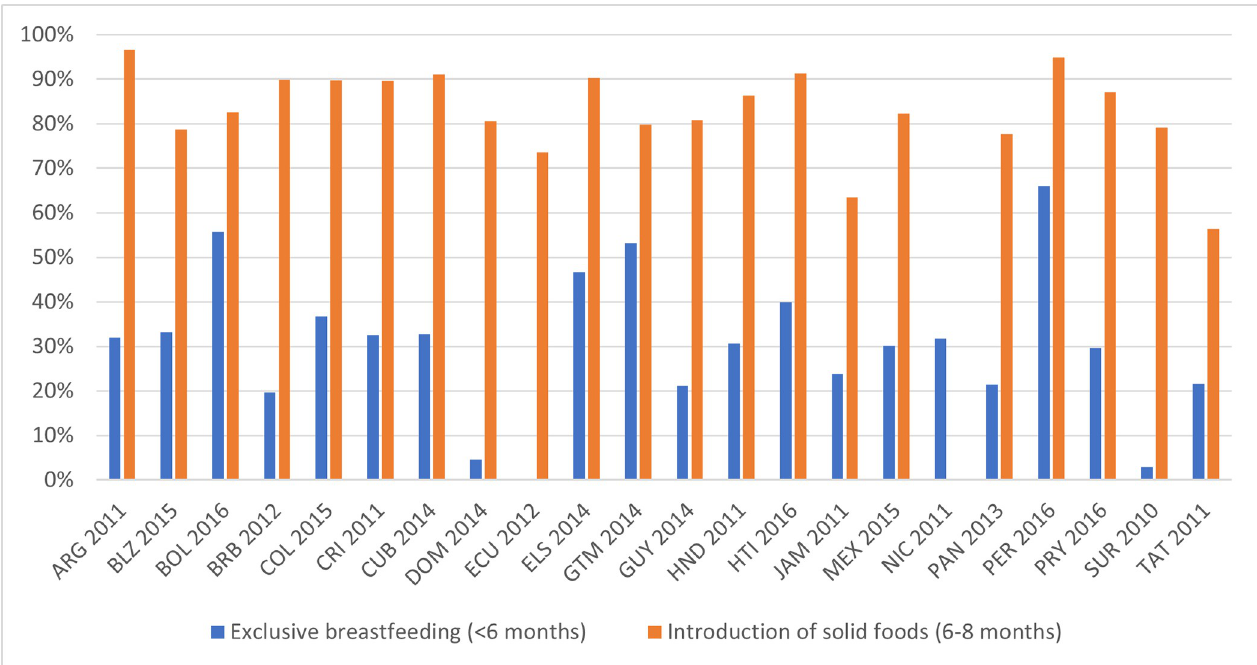
Fig 3. Exclusive breastfeeding and introduction of solid foods in Latin American and the Caribbean countries. Note: The figure shows the prevalence of exclusive breastfeeding among children < 6 months and the share of infants aged 6–8 months who are introduced to solid foods for each country using the latest available data since 2010. Abbreviations: ARG: Argentina, BLZ: Belize, BOL: Bolivia, BRB: Barbados, COL: Colombia, CRI: Costa Rica, CUB: Cuba, DOM: Dominican Republic, ECU: Ecuador, ELS: El Salvador, GTM: Guatemala, GUY: Guyana, HND: Honduras, HTI: Haiti, JAM: Jamaica, MEX: Mexico, NIC: Nicaragua, PAN: Panama, PER: Peru, PRY: Paraguay, SUR: Suriname, TAT: Trinidad and Tobago. Source: authors’ calculations based on UNICEF Global